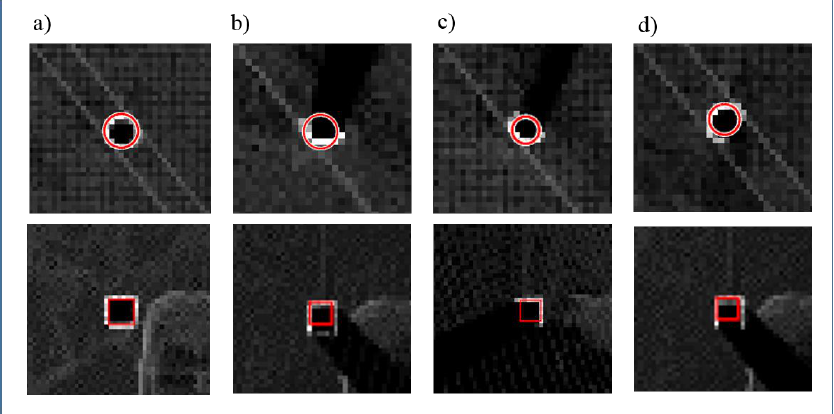
Figure 10. For each case study per column, an example of a column successfully detected with independence of data completeness. The results are shown over the raster image for experiments ( a ), ( b ), ( c ) and ( d